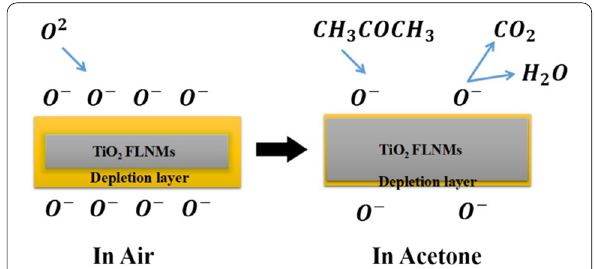
Fig. 8 Sensing mechanism of TiO 2 FLNMs toward ambient air and acetone